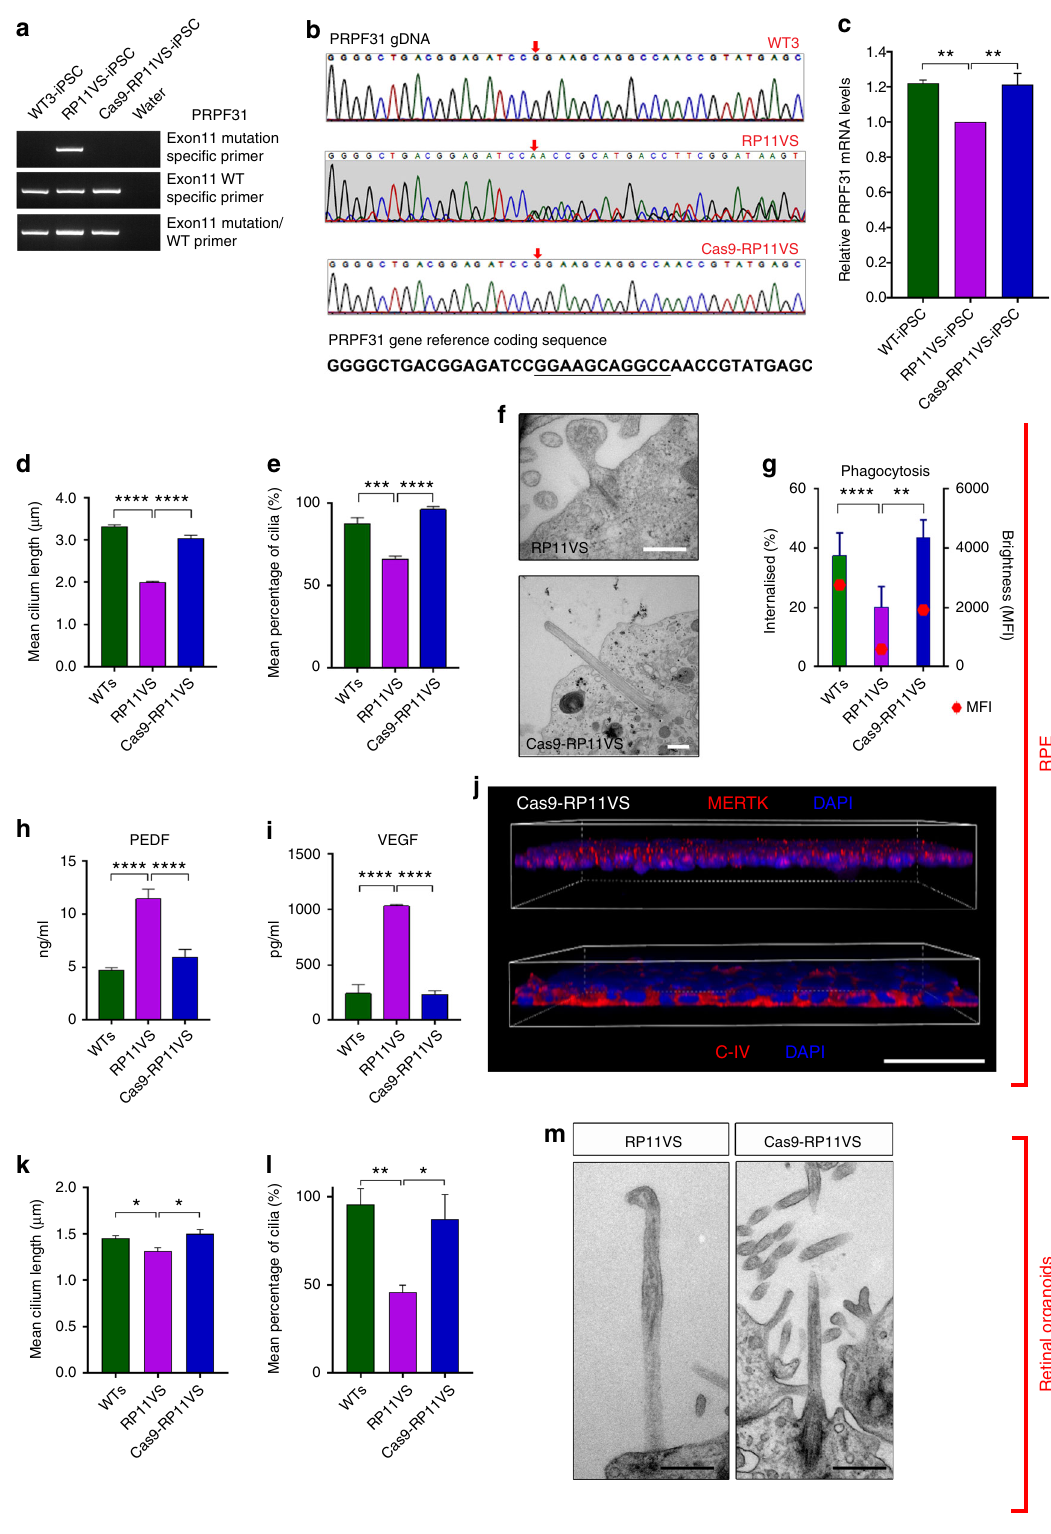
Fig. 7 Gene correction of PRPF31 mutation results in reversal of cellular and functional phenotypes in RPE and photoreceptors. a – c CRISPR/Cas9 correction of the PRPF31 deletion in exon 11; d , e Quanti fi cation of cilia length and incidence in PRPF31- and WT-RPE. f TEM analysis of PRPF31 -edited RPE cilia showing morphologically normal cilia, scale bar: 500 nm; g Increased phagocytosis in PRPF31 -edited RPE. h – j Restoration of apical – basal polarity in PRPF31 -edited RPE, scale bar: 50 μ m. k , l Quanti fi cation of cilia length and frequency in PRPF31 - and WT-photoreceptors; m TEM analysis of PRPF31 -edited photoreceptor cilia showing morphologically normal cilia, scale bar: 500 nm. c – e , g – i , k , l Data shown as mean ± SEM, n = 3. Statistical signi fi cance of pairwise comparisons is indicated by n.s.: not signi fi cant; * p < 0.05; ** p < 0.01; *** p < 0.001; **** p < 0.0001 (Student ’ s paired t